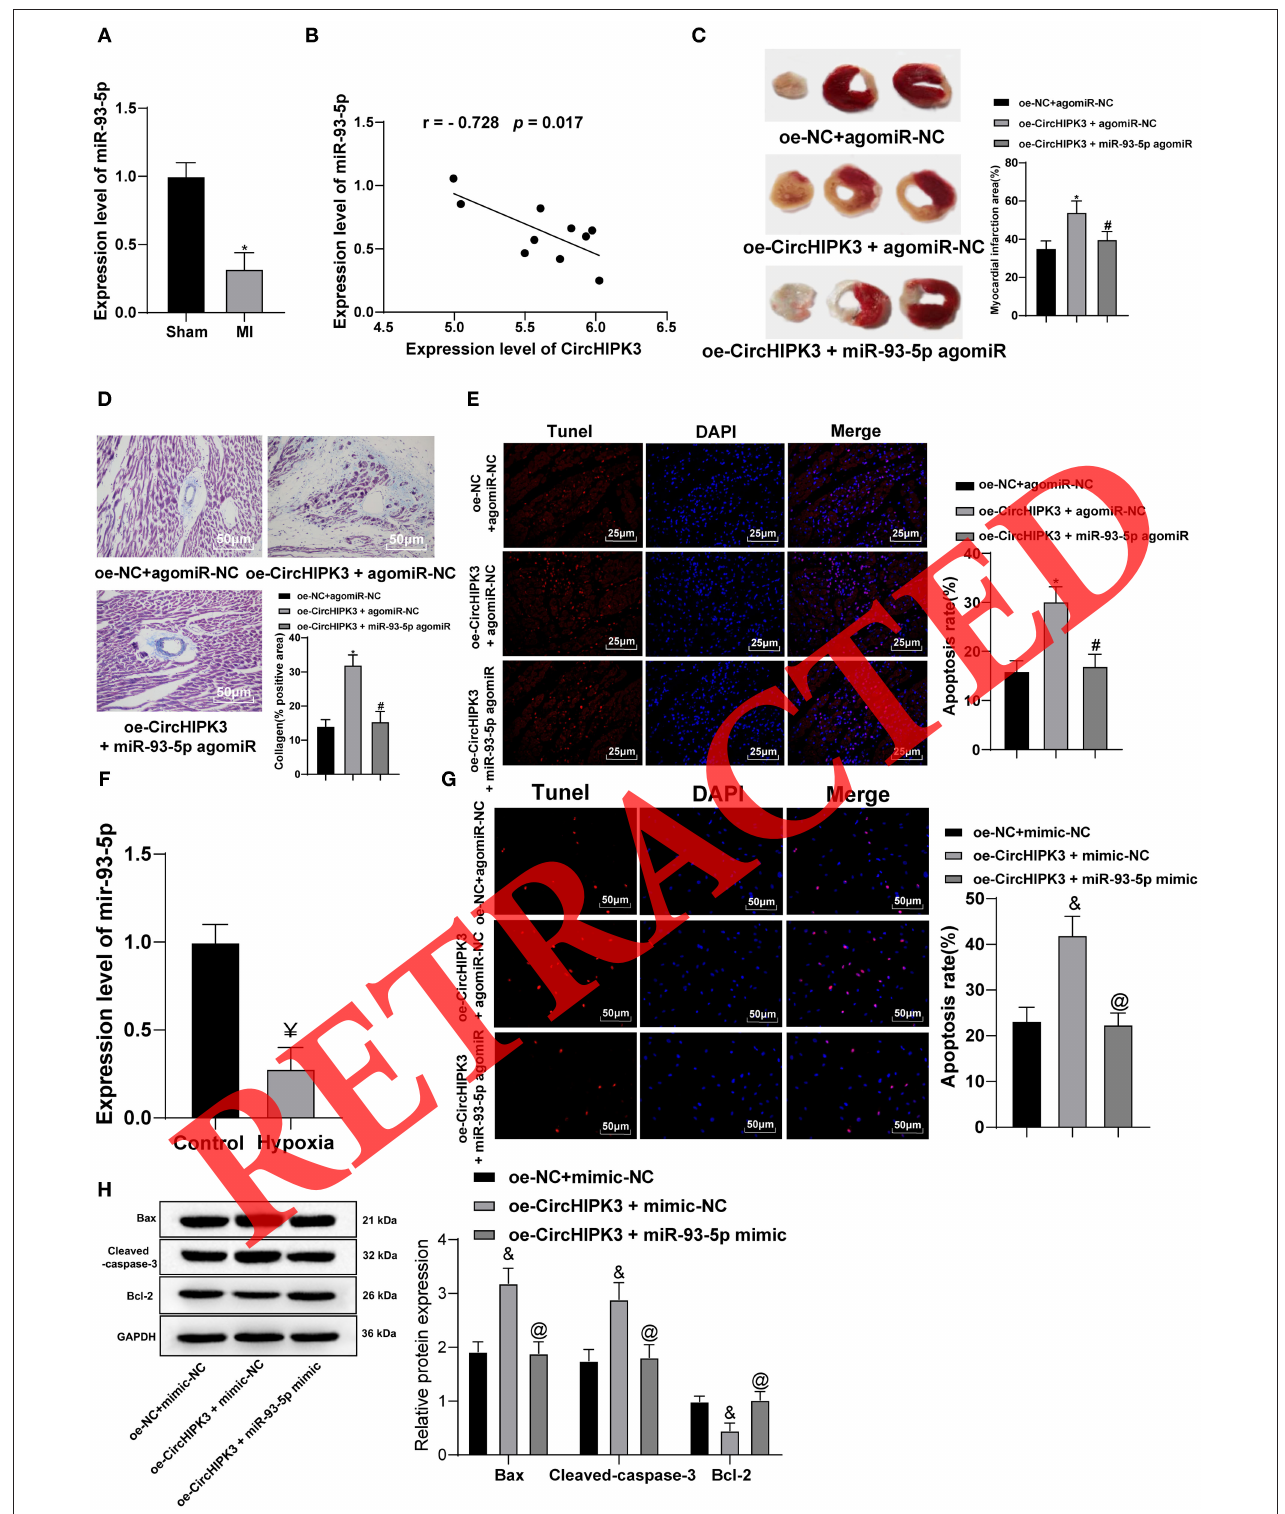
FIGURE 4 | Overexpression of miR-93-5p reverses the myocardial infarction-induced myocardial injury stimulated by CircHIPK3. (A) RT-PCR was used to detect the expression of miR-93-5p in myocardial tissue of mice after modeling. (B) Pearson’s correlation analysis was used to analyze the correlation between miR-93-5p